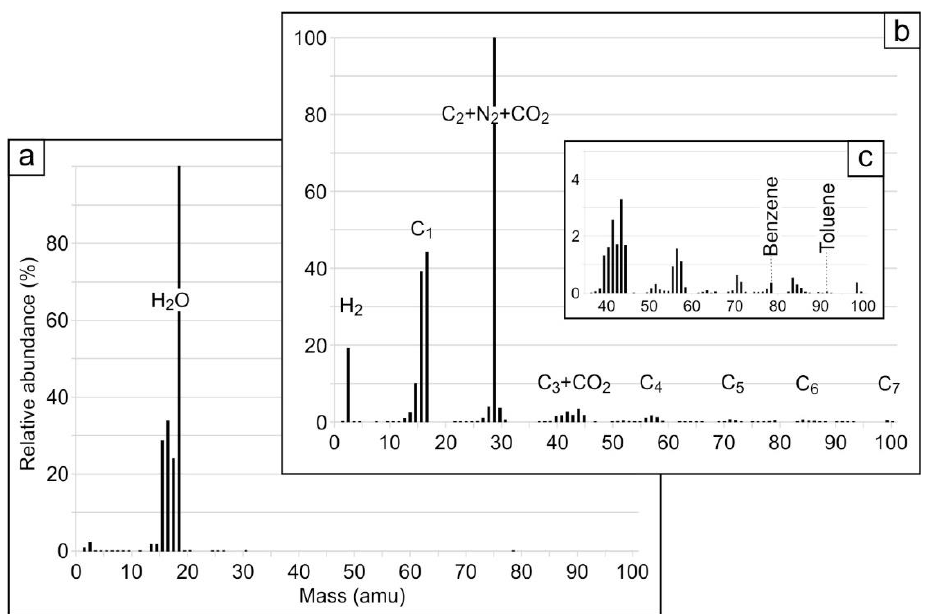
Figure 12. Mass spectra of the fluid remnants characterising ( a ) non-hydrocarbon and ( b , c ) Figure 12. hydrocarbon species.